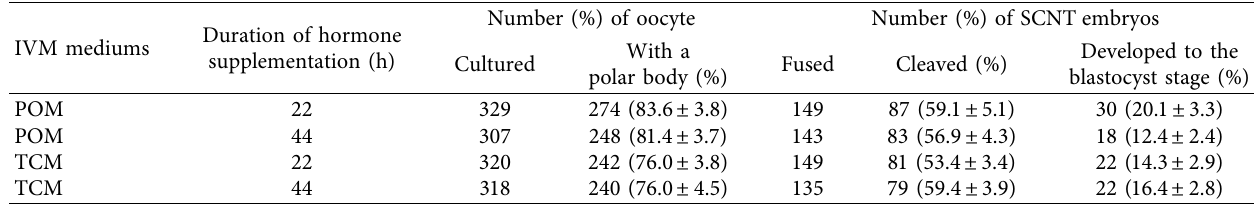
Table 1: Efects of maturation medium and hormone exposure duration on oocyte maturation and developmental competence of Ban Pig somatic cell nuclear transfer (SCNT) embryos ∗ .